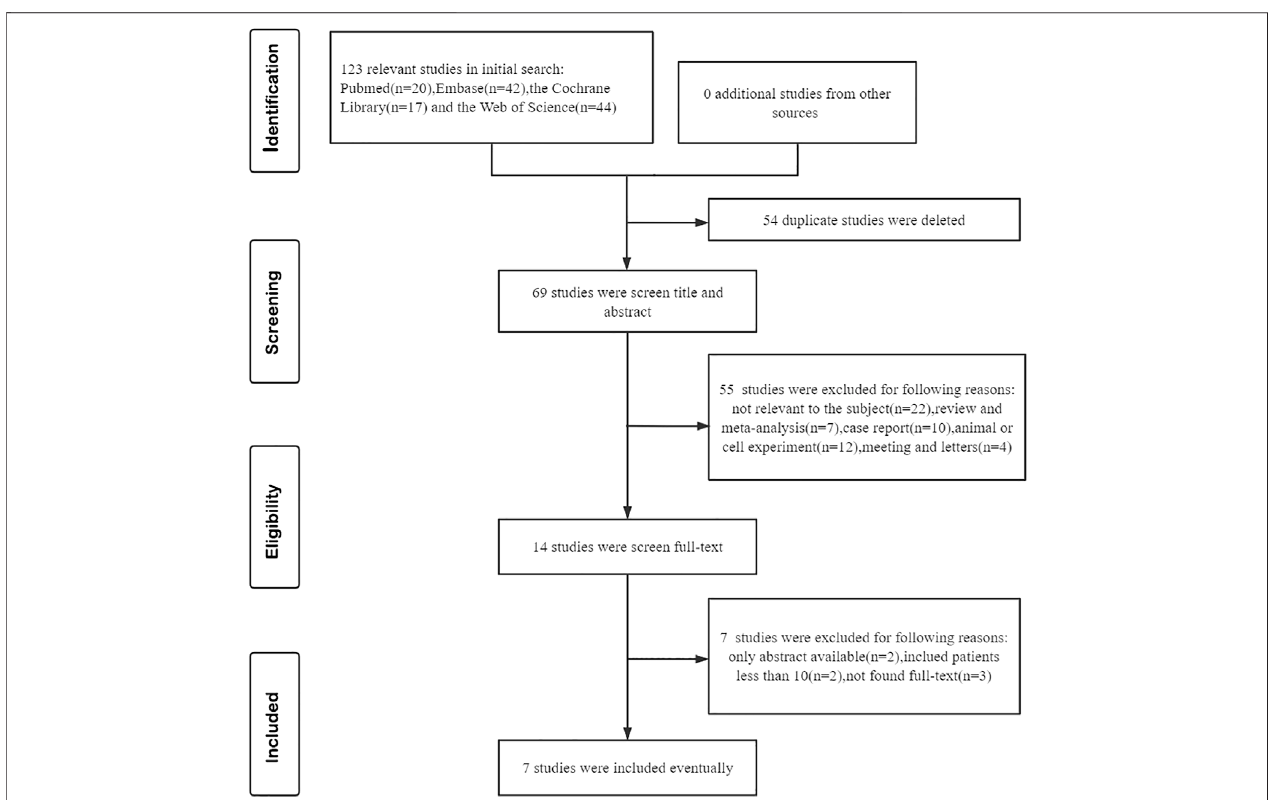
FIGURE 1 | Flow diagram of meta-analysis for inclusion/exclusion of